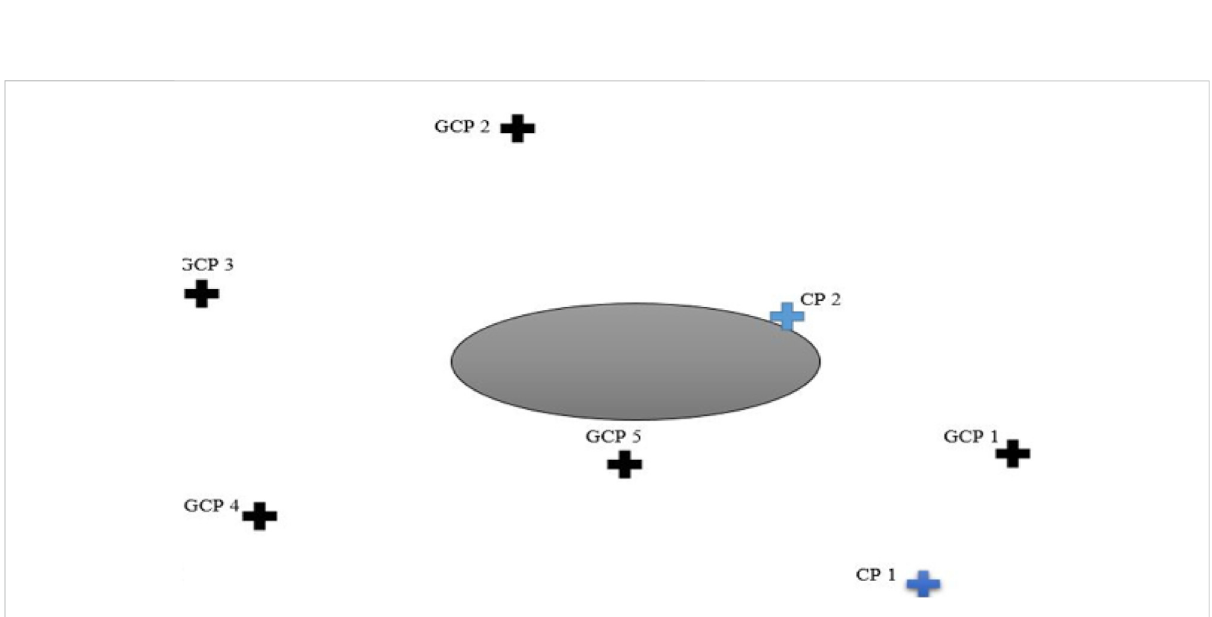
FIGURE 6 Ground control and Checkpoints